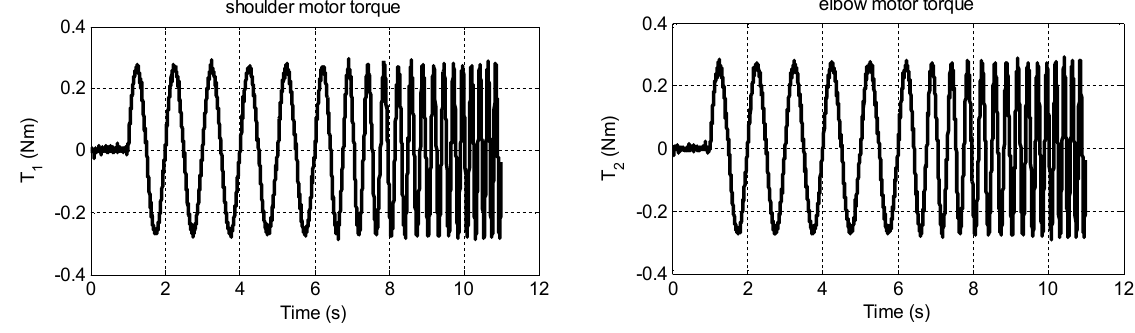
Figure 4. Sine sweep signals to motors.